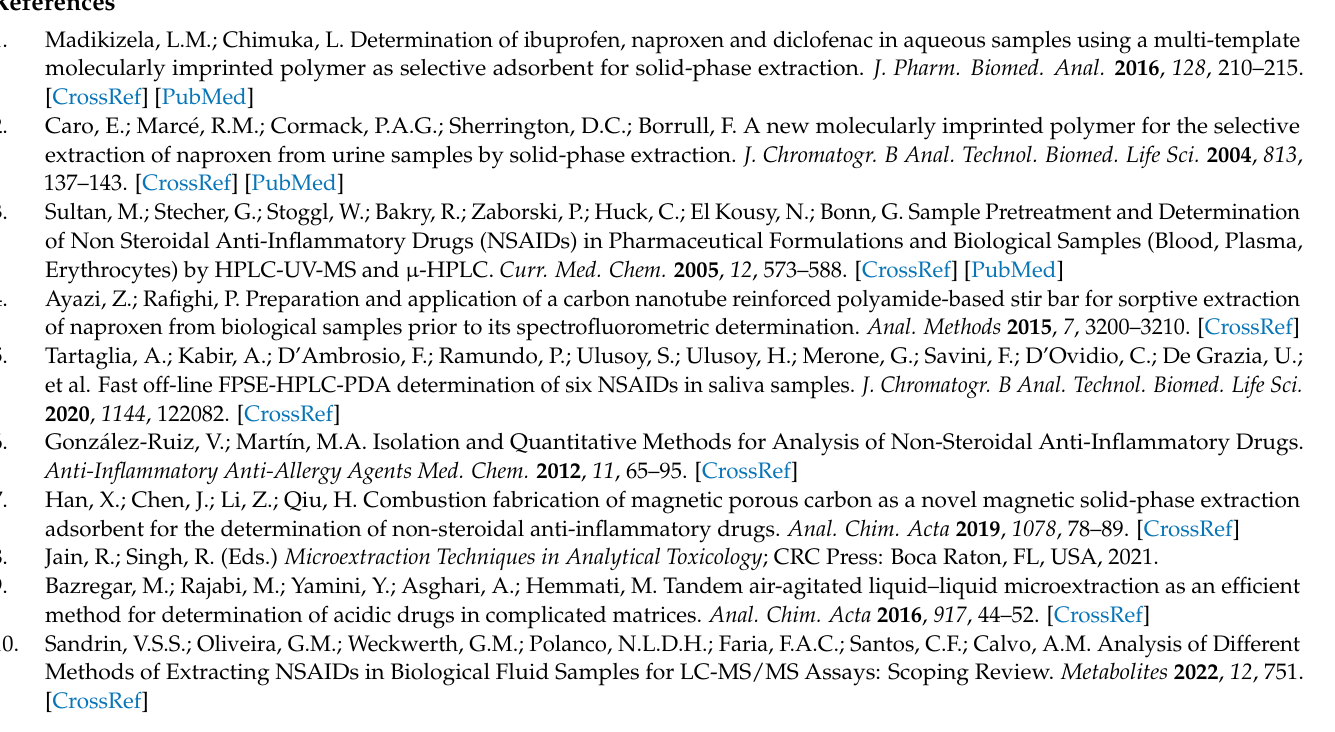
Figure S5: Input parameters and their values in ComplexGAPI software for the proposed